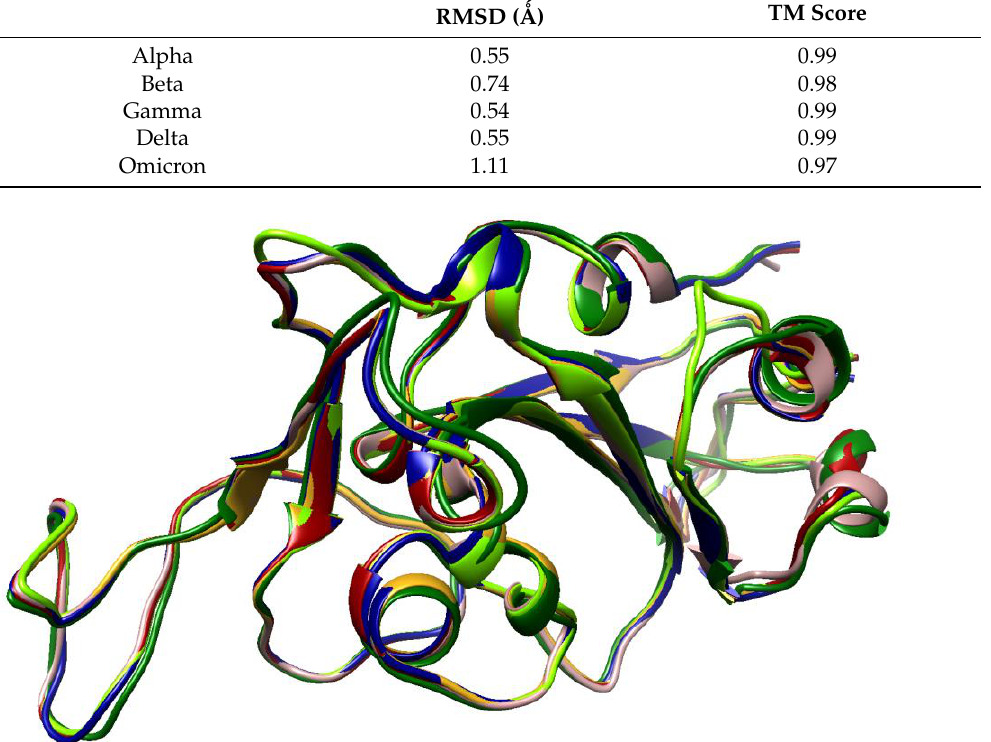
Table 4. Deviations in the structures of the RBD of each VOC compared to the Wuhan original structure.